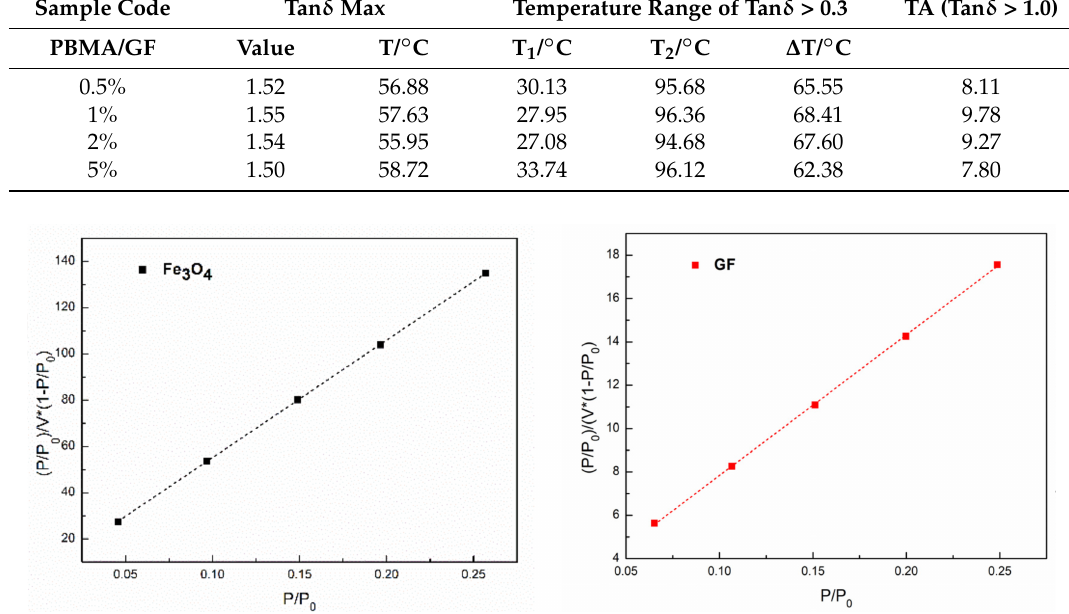
Figure 8. Brunauer-Emmet-Teller (BET) spectra of Fe 3 O 4 and GF measured by a specific surface area and pore size tester. Fitting index, R 2 = 0.99996, 0.99973,